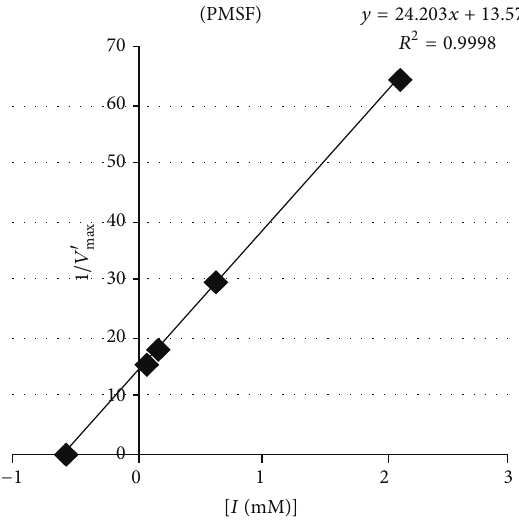
Figure 4: Determination of inhibition constant ( 𝐾 𝑖 ) for